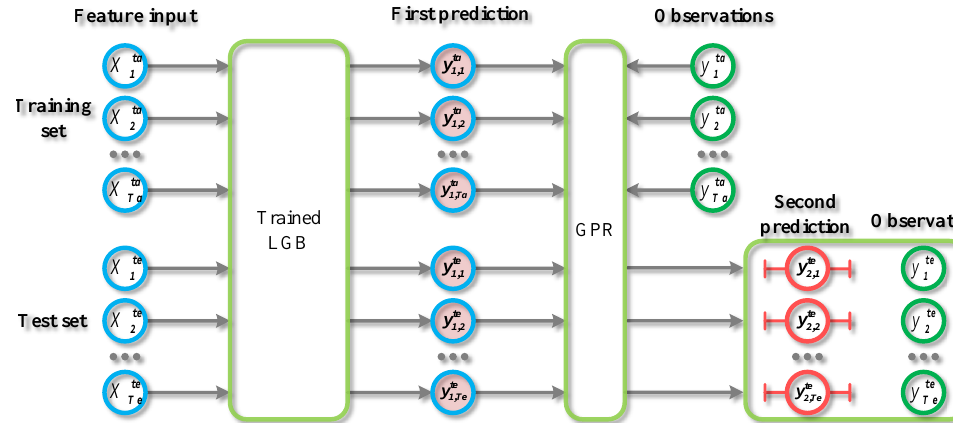
Figure 3. LGB-GPR prediction flow chart.